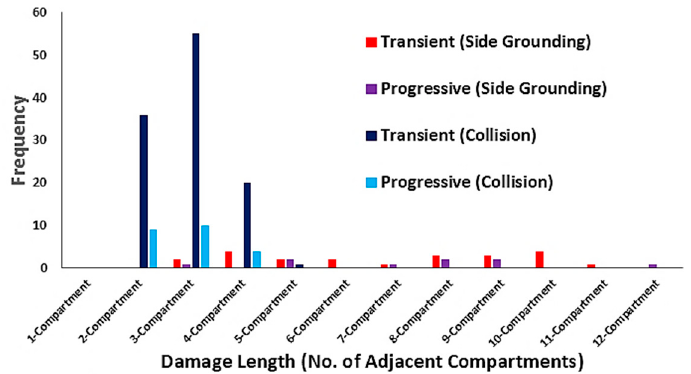
Figure 10. Typical transient loss modality distribution for a SOLAS’90 cruise ship (numerical simulation results).